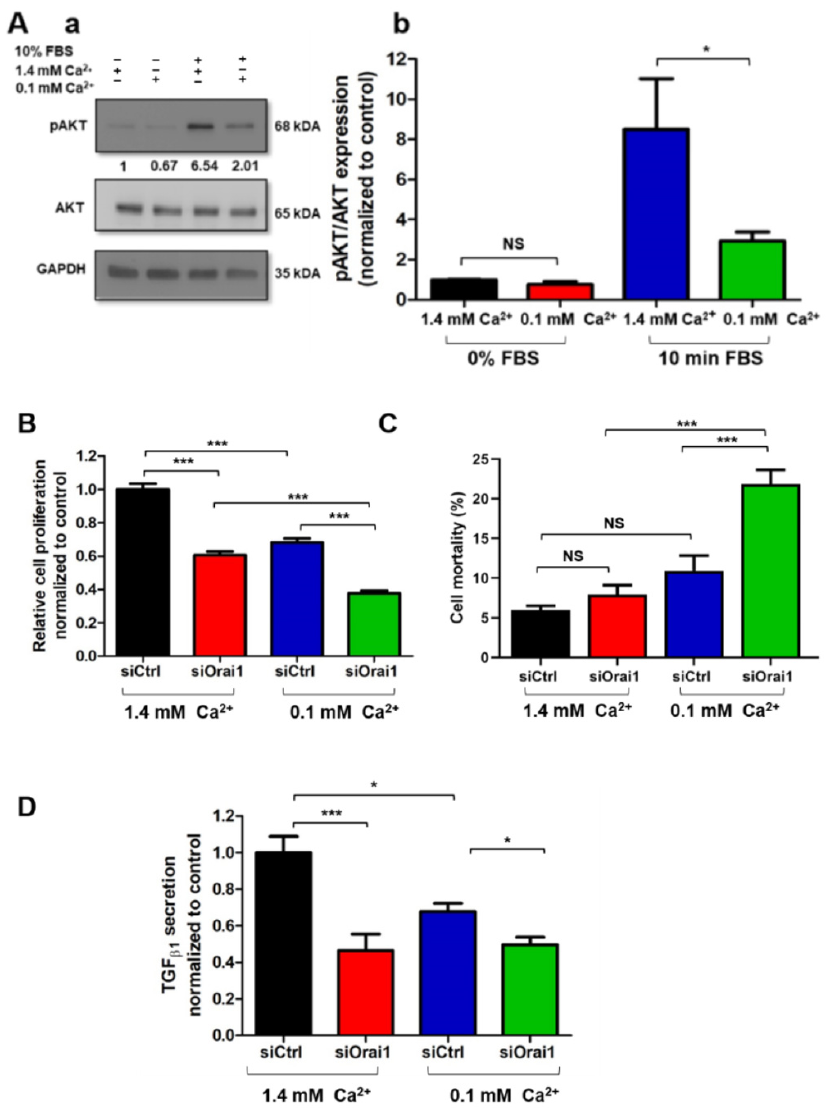
Figure 7 Figure 7. Ca 2+ entry through Orai1 regulates AKT-dependent proliferation and TGF β 1 secretion in PS-1 human-activated PSCs. ( A ) Effect of extracellular Ca 2+ decrease on AKT activation, 72 h post-proliferation, after overnight FBS starvation of no transfected cells. Then PS-1 cells were pre- treated for 30 min with 1.3 mM EGTA in order to reduce the extracellular Ca 2+ concentration (0.1 mM Ca 2+ ), with (+) and without (-) 10 min of 10% FBS stimulation. Representative Western blot of low extracellular Ca 2+ concentration impact on AKT phosphorylation ( Aa ). AKT activation was evaluated as described previously, by the ratio of phosphorylated AKT form/total AKT protein (1.4 mM Ca 2+ +10 min FBS: 8.5 ± 2.52-fold, 0.1 mM Ca 2+ + 10 min FBS: 2.92 ± 0.46-fold, N = 3, * p < 0.05, NS, two-way ANOVA followed by Bonferroni post hoc test, ( Ab ). Values were first normalized to the referent protein GAPDH and then to the 0% FBS + 1.4 mM Ca 2+ condition, reported as mean ±